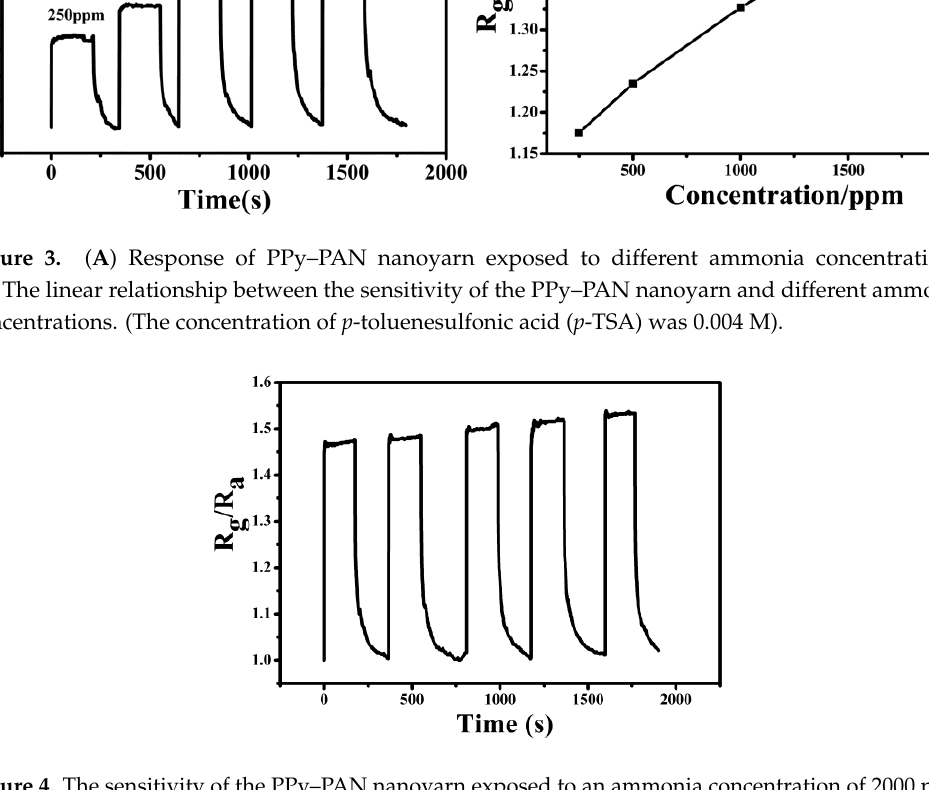
Figure 4. The sensitivity of the PPy–PAN nanoyarn exposed to an ammonia concentration of 2000 ppm during cycle tests. (The concentration of p -toluenesulfonic acid ( p -TSA) was 0.004 M).